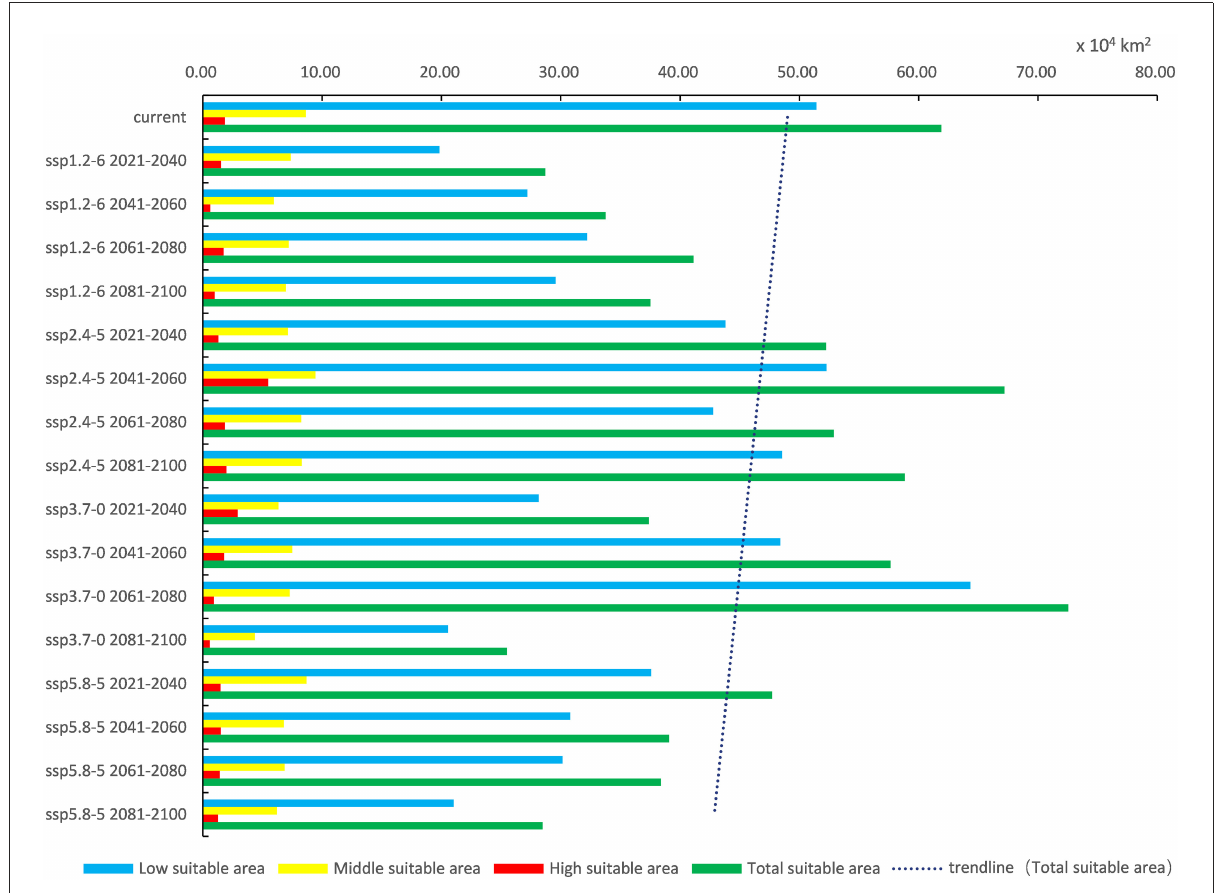
FIGURE8 Variation trend of suitable areas for O. sexdentatus in China under current and future climate scenarios.